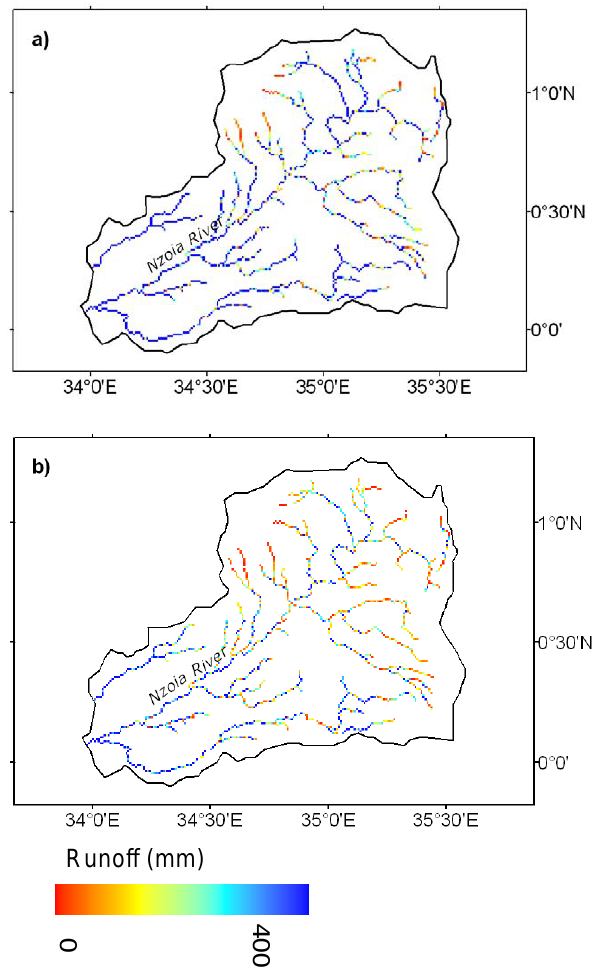
Fig. 7. Spatially distributed runoff averaged over study period (1996–2006) during (a) wet season from March to June and (b) dry season from November to February.